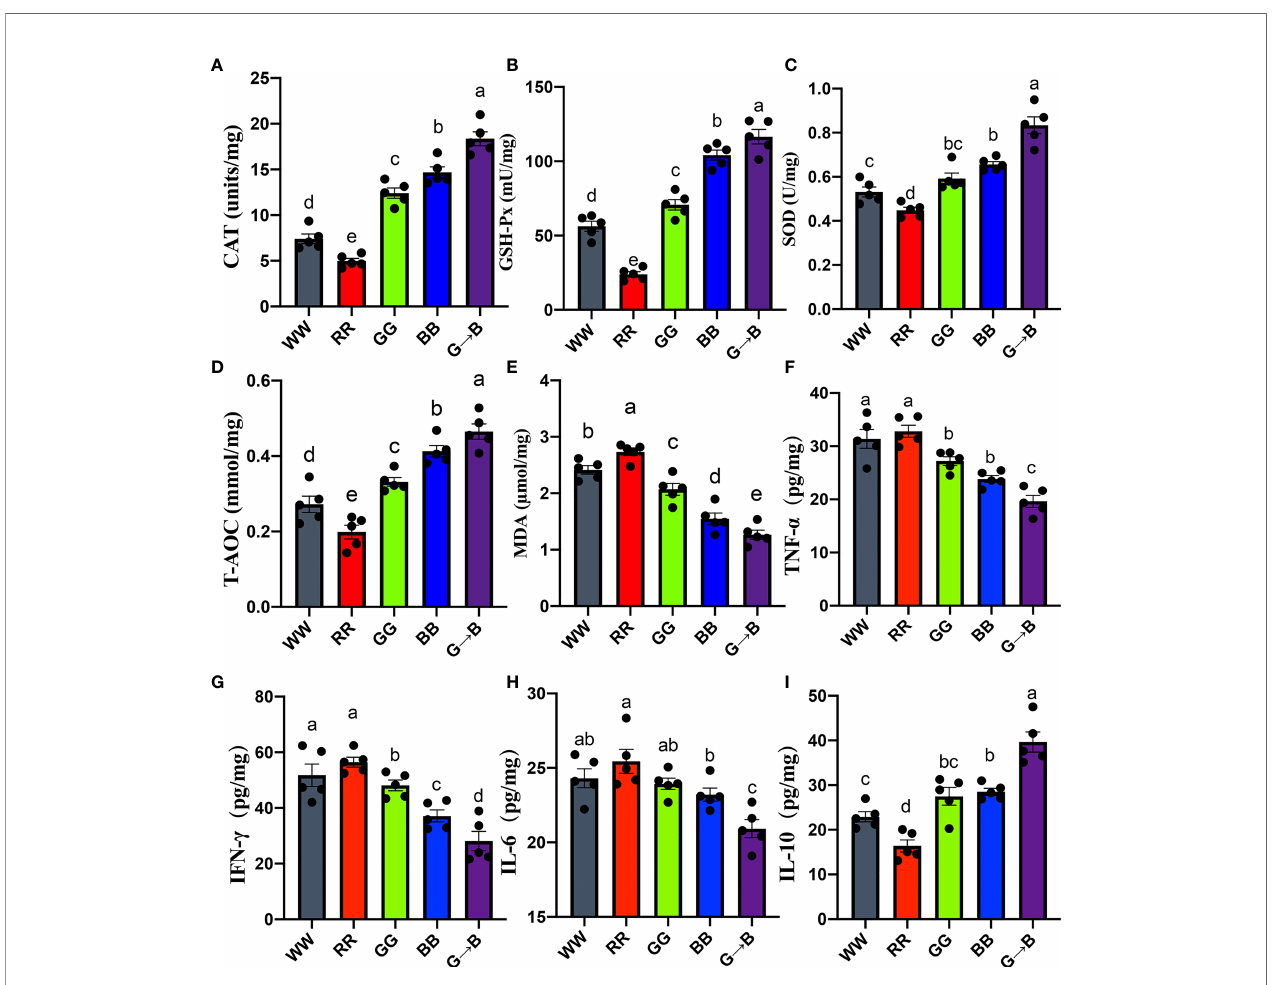
FIGURE 7 | Effect of different monochromatic light combinations on CAT (A) , GSH-Px (B) , SOD (C) , T-AOC (D) , MDA (E) , pro-in fl ammatory cytokine TNF- a (F) , IFN- g (G) , IL-6 (H) , and anti-in fl ammatory cytokine IL-10 (I) concentrations in the cecum at P42. WW, white light; RR, red light; GG, green light; BB, blue light; G ! B, green light and blue light combination. The results are presented as means ± SEM. Different letters indicate signi fi cant differences between the treatments at the same age ( P <